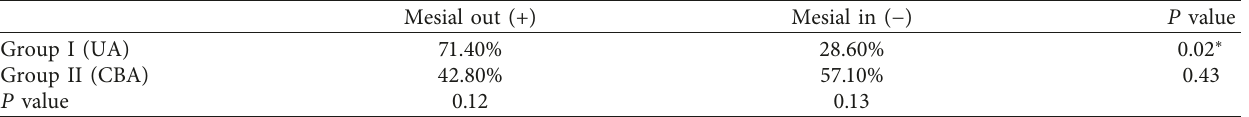
Table 4: Rotational (angular) directional